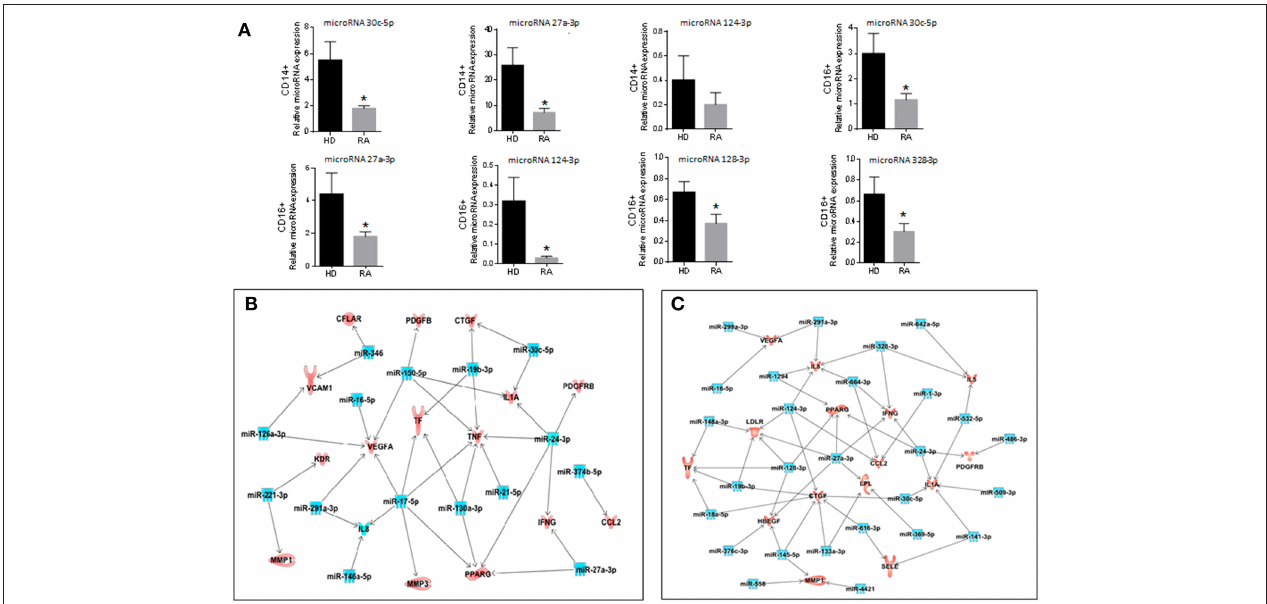
FIGURE 5 | Validation of the microRNA array and integrated analysis between the microRNAs and genes altered in CD14 + and CD16 + RA monocytes. (A) mRNA relative expression of microRNAs in CD14 + and CD16 + monocytes from RA patients and HDs. Data are presented as mean ± SD, n = 50 RA patients and 33 HDs. Paired t -test was performed (*) indicates significant differences vs. HDs ( p < 0.05). (B) Integrated analysis of altered microRNAs (microRNA array) and mRNA gene expression (PCR array) in CD14 + RA monocytes. (C) Integrated analysis of altered microRNAs (microRNA array) and mRNA gene expression (PCR array) in CD16 + RA monocytes. Interaction networks of altered microRNAs and genes related to atherosclerosis using IPA